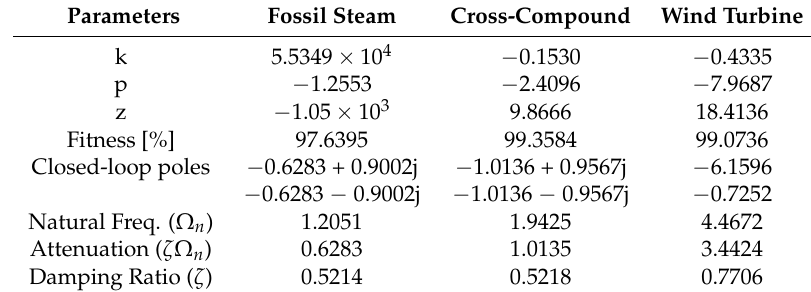
Table 1. Analytical model parameters of considered fossil steam generator, cross-compound generator and wind turbine generator.